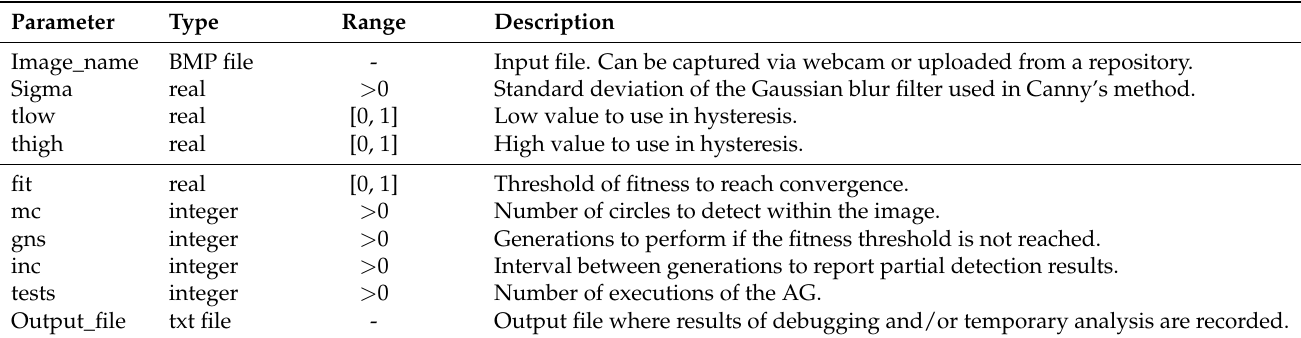
Table 2. CDS input parameters